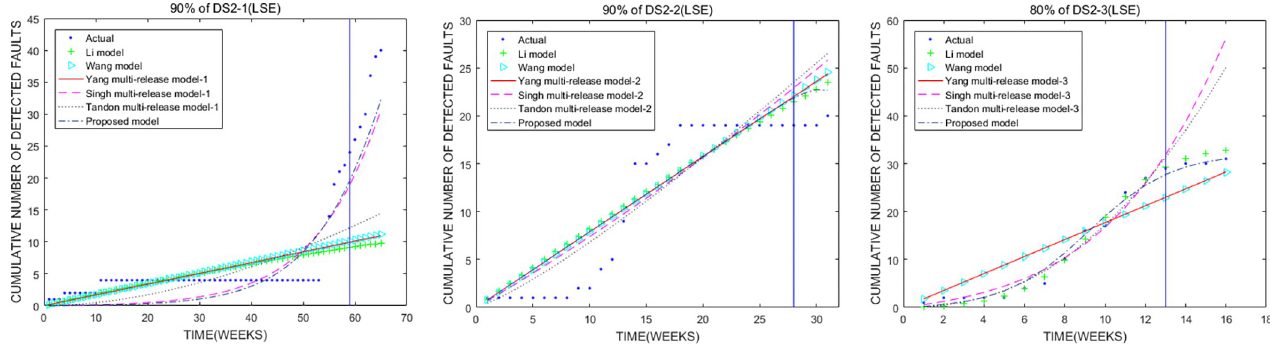
Fig 2. Comparison of the cumulative number of faults estimated by the models using Apache Chemistry OpenCMIS (DS2). (a), (b), and (c) represent the cumulative number comparison of faults estimated by models using 90%, 90%, and 80% of fault data (OpenCMIS 0.4.0, OpenCMIS 0.5.0, and OpenCMIS 0.6.0), respectively.